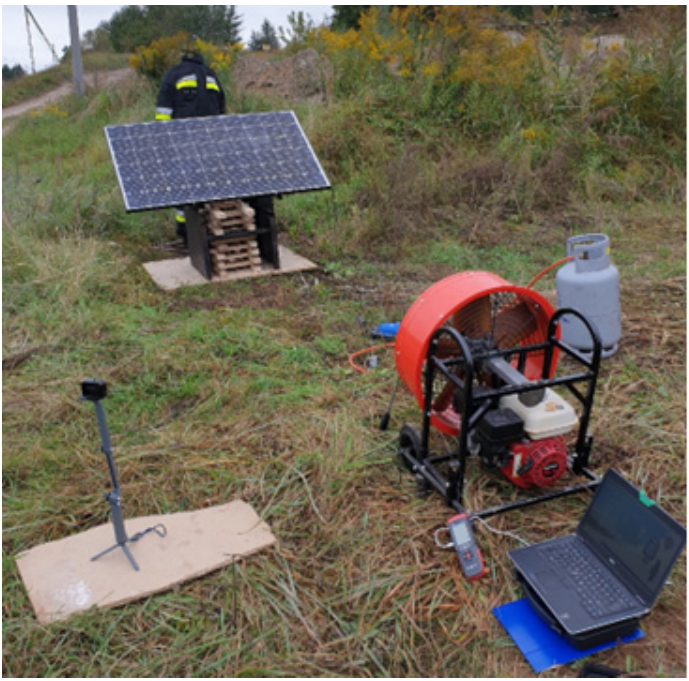
Figure 3. Scenario Test 1 with a PV module fire in an open space. The photograph shows the test stand and the fan that directed the airflow to the PPC.